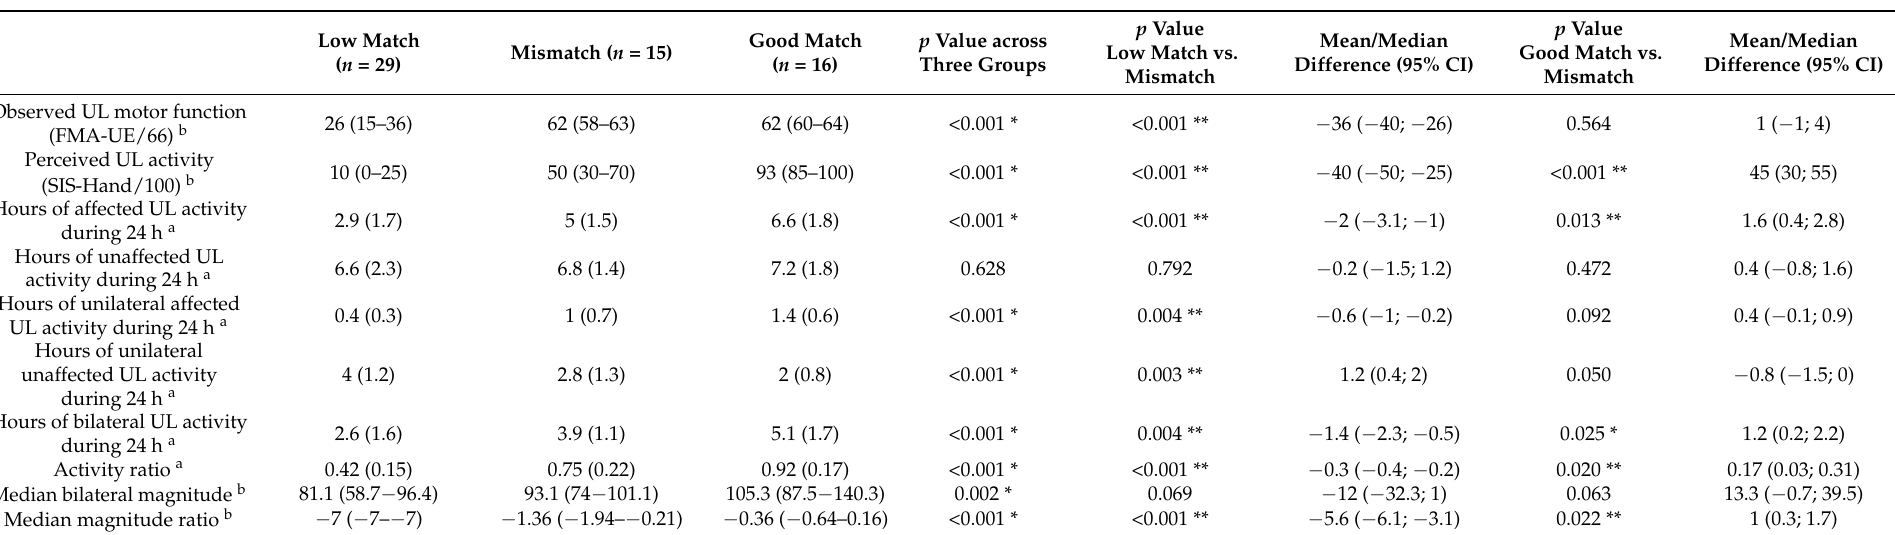
Table 3. Upper limb functioning and accelerometry outcomes over 24 h across the three groups presented as mean (SD) or median